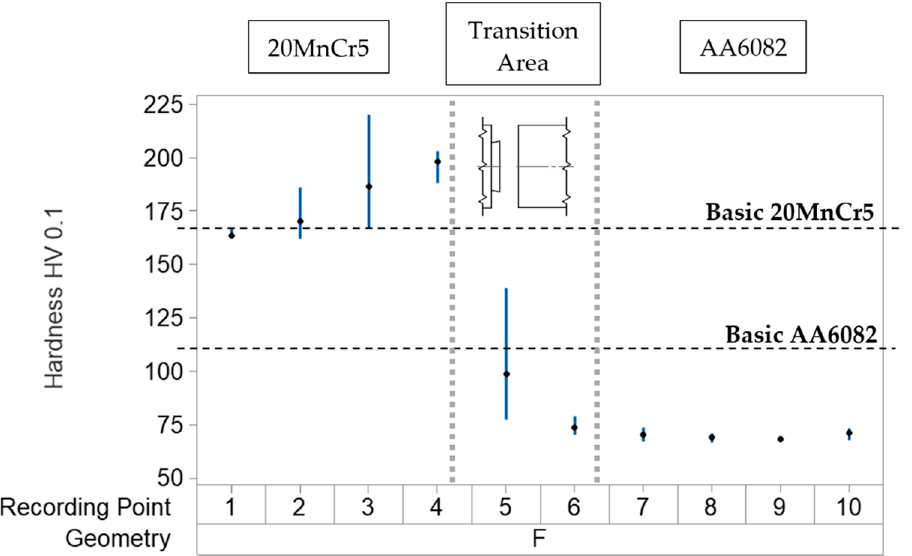
Figure 11. Diagram of the hardness of a sample with Geometry F including the variance, range between recording points is approximately 0.5 mm.